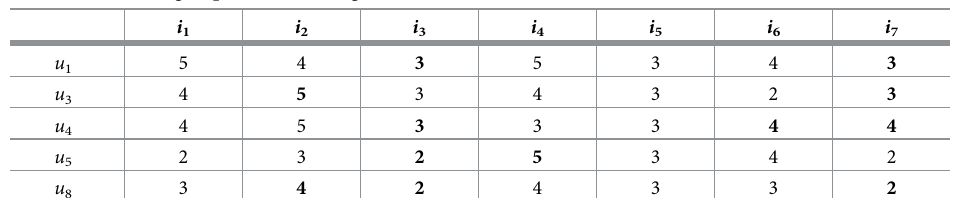
Table 10. Predicted group members ratings.